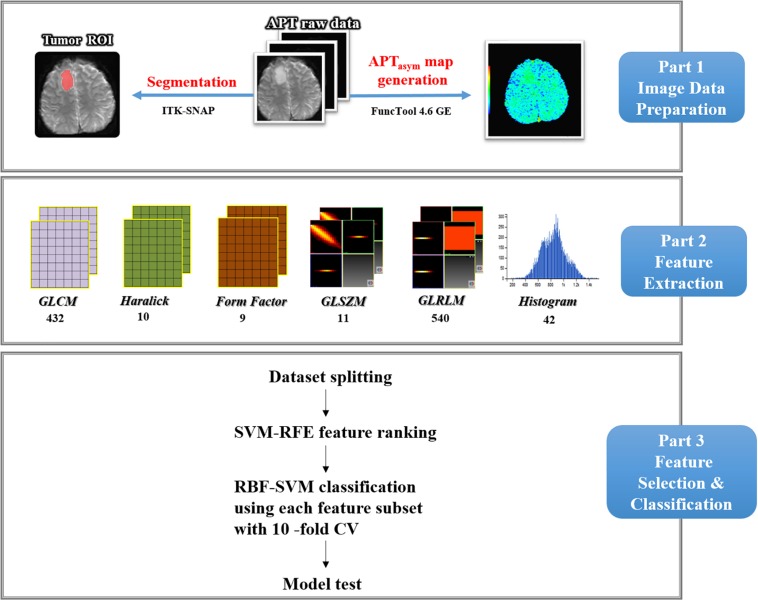
Study flow chart. First, APTasym map was generated from APT raw data and ROI segmentation was done. Second, six types of texture features within ROIs were extracted by using Analysis-Kinetics software, including the histogram, form, GLCM, GLRLM, GLSZM, and Haralick features. At last, automatic glioma IDH1 mutation classification using RBF-SVM combined with SVM-RFE feature selection and 10-fold cross-validation were carried out. Finally, model was tested by the pre-reserved test data.